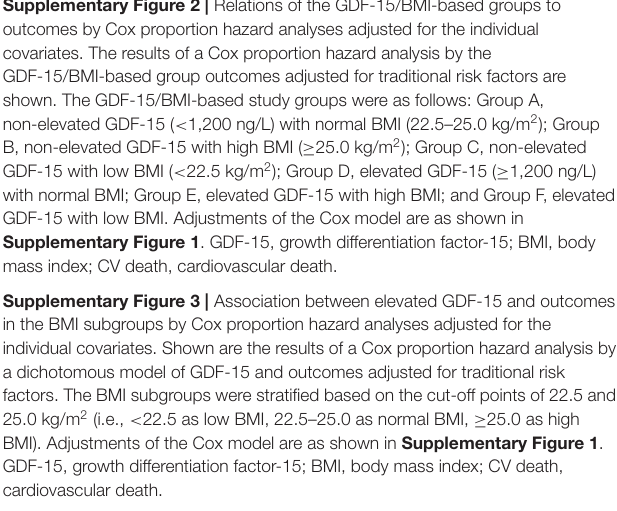
Supplementary Figure 1 | Association between GDF-15 and outcomes by Cox proportion hazard analyses adjusted for the individual covariates. Shown are the results of a Cox proportion hazard analysis by continuous and dichotomous models of GDF-15 and outcomes adjusted for age, sex, current smoking, diabetes mellitus, previous CV event, statin use, anti-hypertensive drug use, total cholesterol, high-density lipoprotein cholesterol, office systolic blood pressure, estimated glomerular filtration rate, daily drinker, and high sensitive C reactive protein (log). GDF-15, growth differentiation factor-15; CV death, cardiovascular death; HR, hazard ratio; 95%CI, 95% confidence interval. Supplementary Figure 2 | Relations of the GDF-15/BMI-based groups to outcomes by Cox proportion hazard analyses adjusted for the individual covariates. The results of a Cox proportion hazard analysis by the GDF-15/BMI-based group outcomes adjusted for traditional risk factors are shown. The GDF-15/BMI-based study groups were as follows: Group A, non-elevated GDF-15 ( < 1,200 ng/L) with normal BMI (22.5–25.0 kg/m 2 ); Group B, non-elevated GDF-15 with high BMI ( ≥ 25.0 kg/m 2 ); Group C, non-elevated GDF-15 with low BMI ( < 22.5 kg/m 2 ); Group D, elevated GDF-15 ( ≥ 1,200 ng/L) with normal BMI; Group E, elevated GDF-15 with high BMI; and Group F, elevated GDF-15 with low BMI. Adjustments of the Cox model are as shown in Supplementary Figure 1 . GDF-15, growth differentiation factor-15; BMI, body mass index; CV death, cardiovascular death. Supplementary Figure 3 | Association between elevated GDF-15 and outcomes in the BMI subgroups by Cox proportion hazard analyses adjusted for the individual covariates. Shown are the results of a Cox proportion hazard analysis by a dichotomous model of GDF-15 and outcomes adjusted for traditional risk factors. The BMI subgroups were stratified based on the cut-off points of 22.5 and 25.0 kg/m 2 (i.e., < 22.5 as low BMI, 22.5–25.0 as normal BMI, ≥ 25.0 as high BMI). Adjustments of the Cox model are as shown in Supplementary Figure 1 . GDF-15, growth differentiation factor-15; BMI, body mass index; CV death, cardiovascular death. Supplementary Table 1 | Cause of